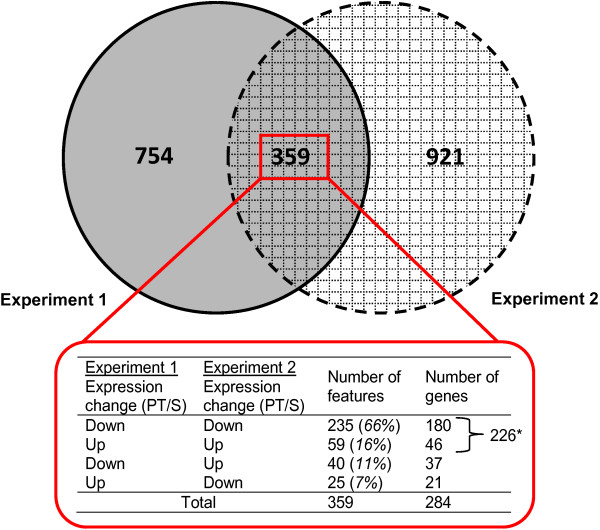
Comparison of microarray features differentially expressed across salmon louse strains between experiments. Genes differentially expressed between two salmon lice strains differing in EMB susceptibility (S, PT) were determined by microarray analysis in two independent experiments. Features that showed differential expression between strains (fold change ≥ 1.3, p < 0.05) were derived for both experiments. The Venn diagram only includes features studied in both experiments. *A total of 226 genes showed comparable differential expression between salmon louse strains in two independent microarray experiments and were therefore selected for further analysis of biological function.